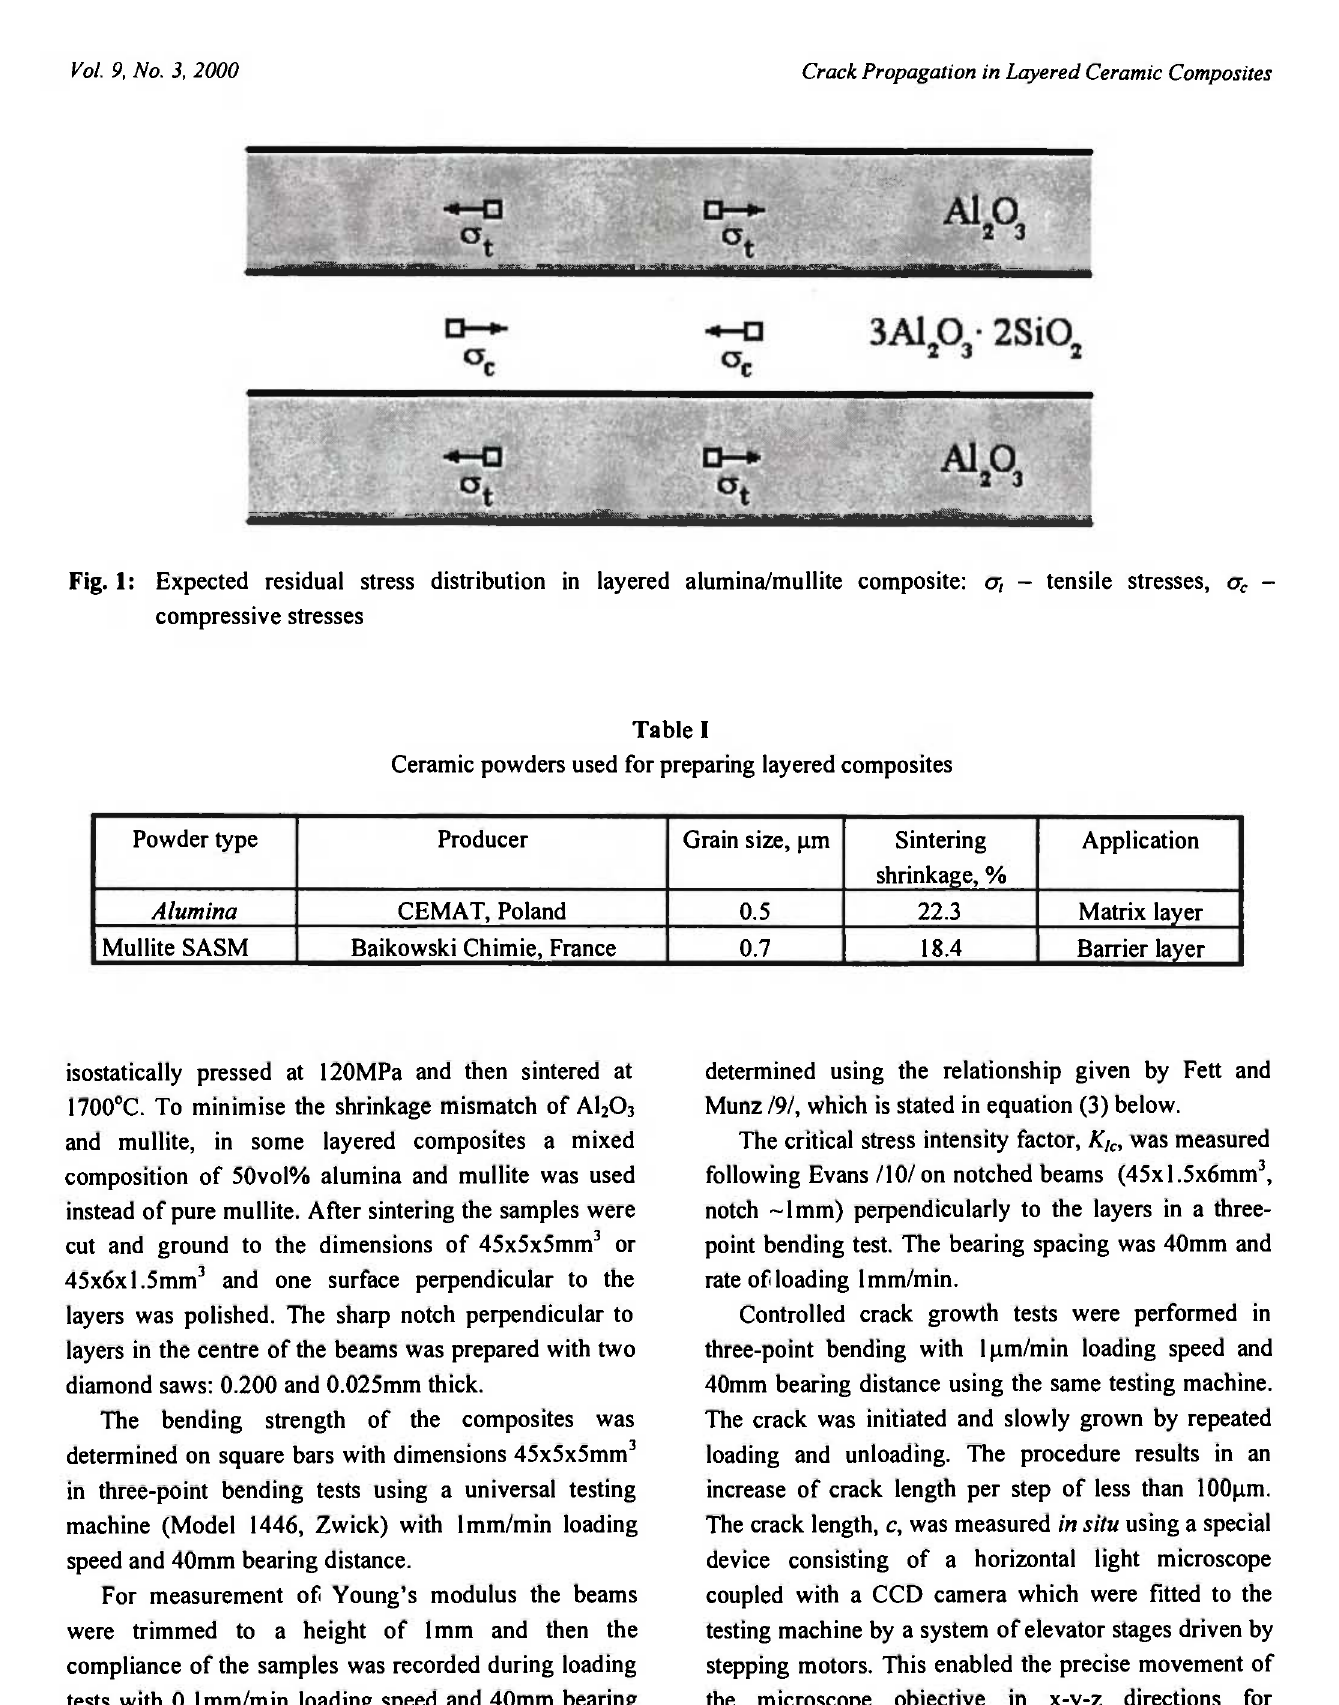
Fig. 1: Expected residual stress distribution in layered alumina/mullite composite: σ, - tensile stresses, a c - compressive stresses